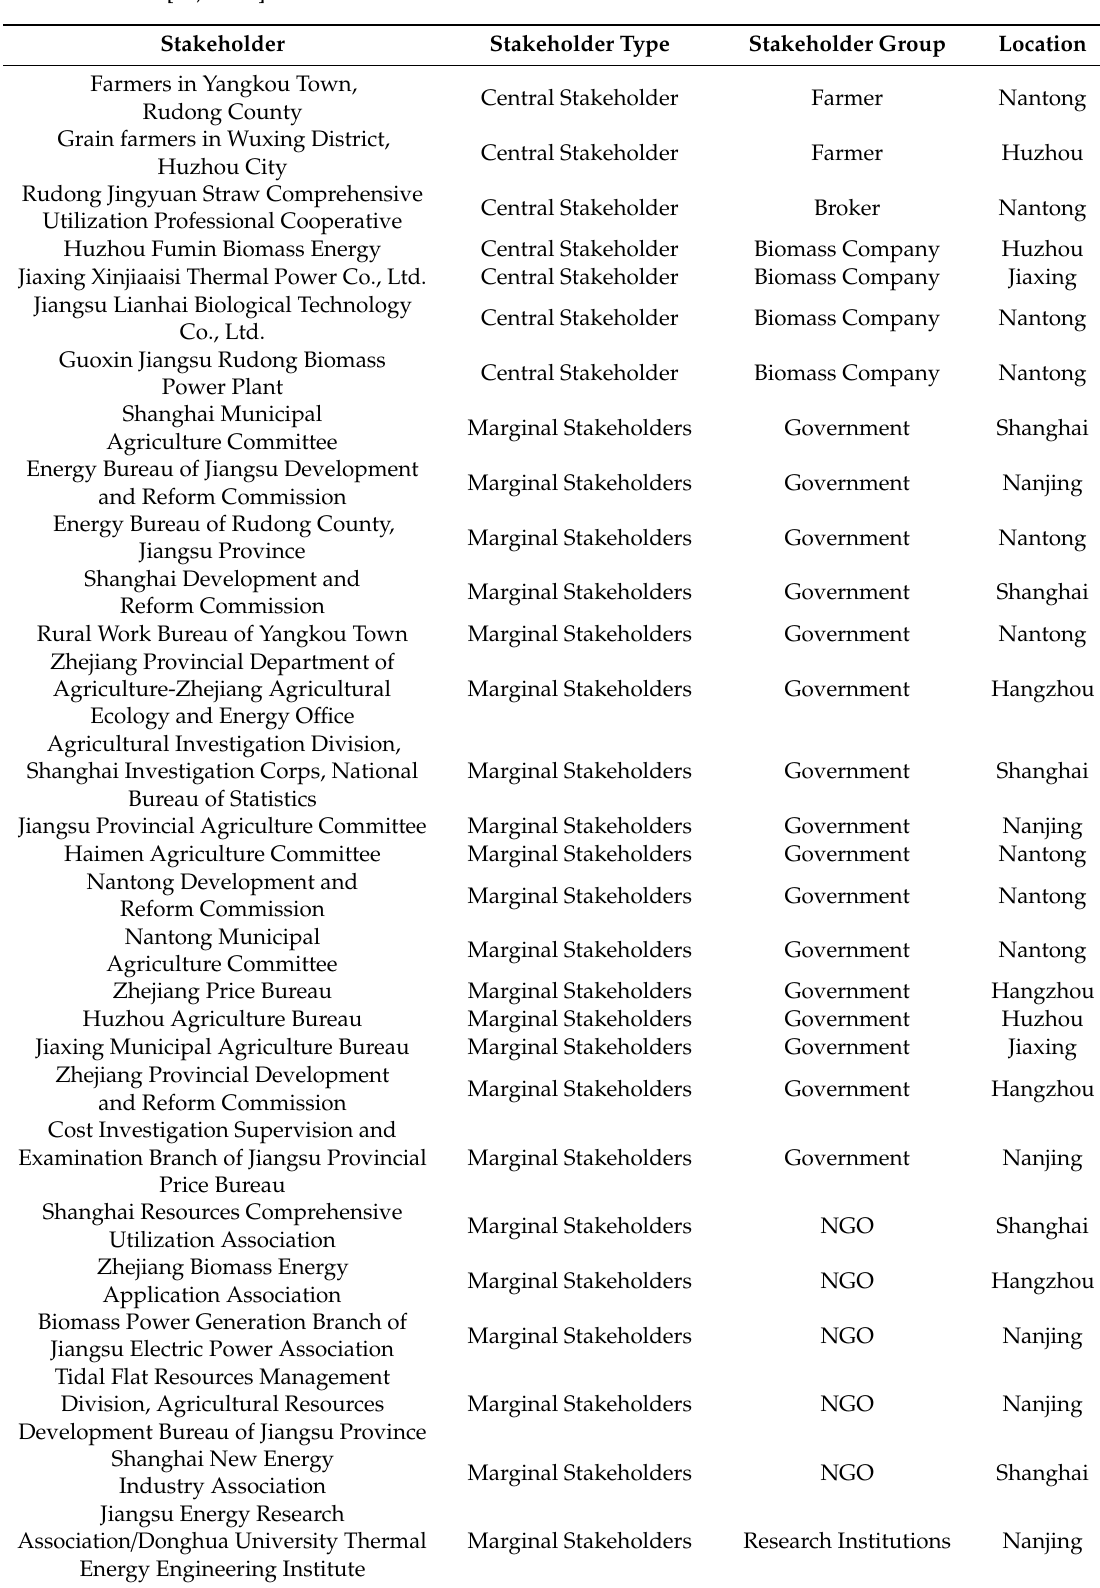
Table 2. Stakeholder groups in the biomass energy industry in the Yangtze River Delta for in-depth interviews